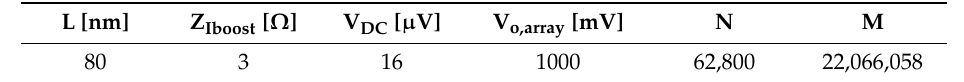
Table 4. Parameters of a Rectennas Array.